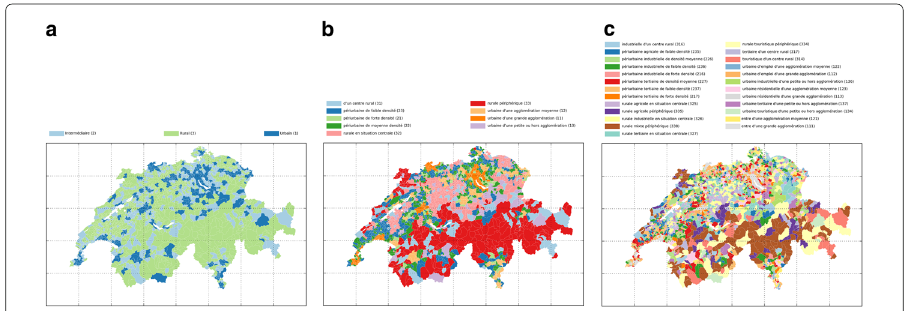
Fig. 5 Illustration of the maps of the official classifications, from a to c the parameters are: m = 3; m = 9; m =